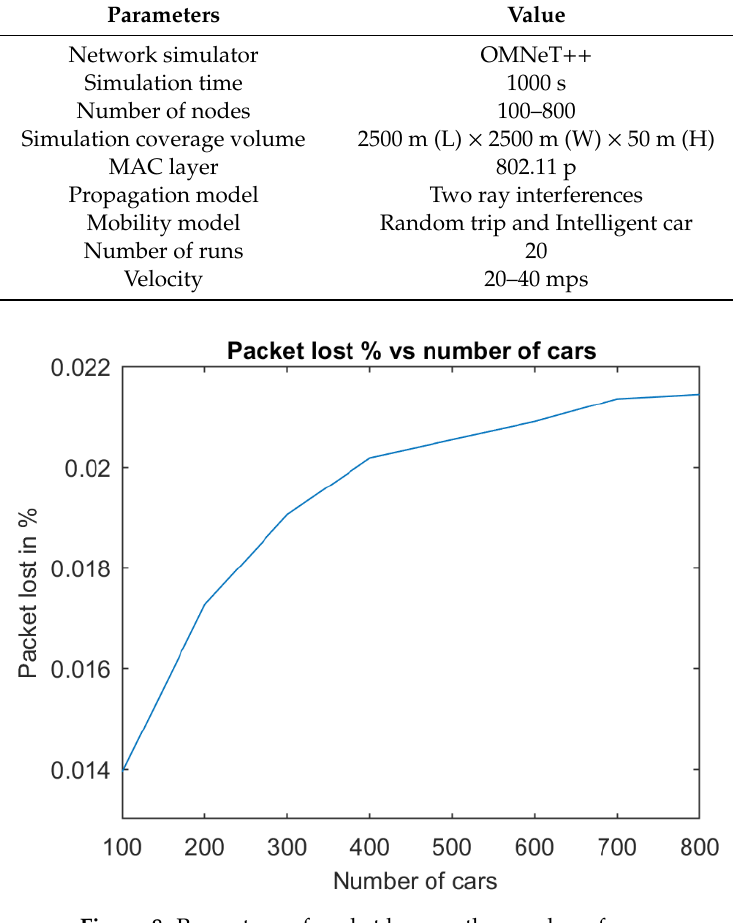
Figure 8. Percentage of packet loss vs. the number of cars.